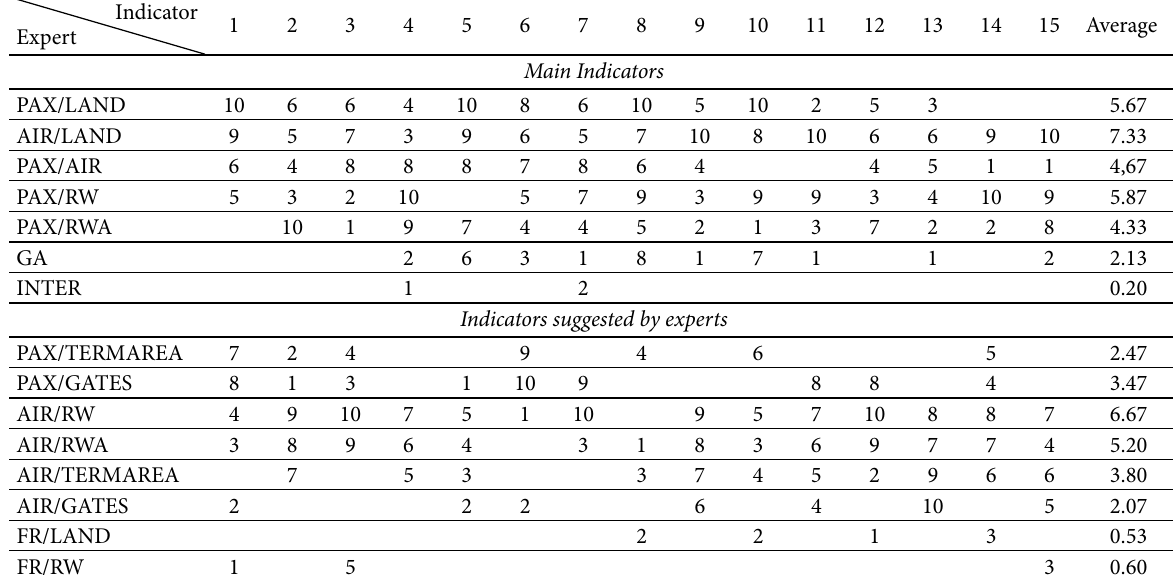
Table 3. The results evaluated by Delphi in the first round Indicator